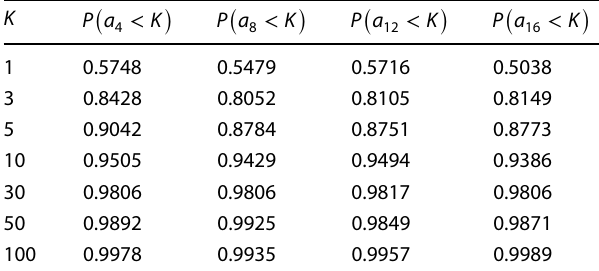
Table 1 Probability distributions of the 4th, 8th, 12th, and 16th